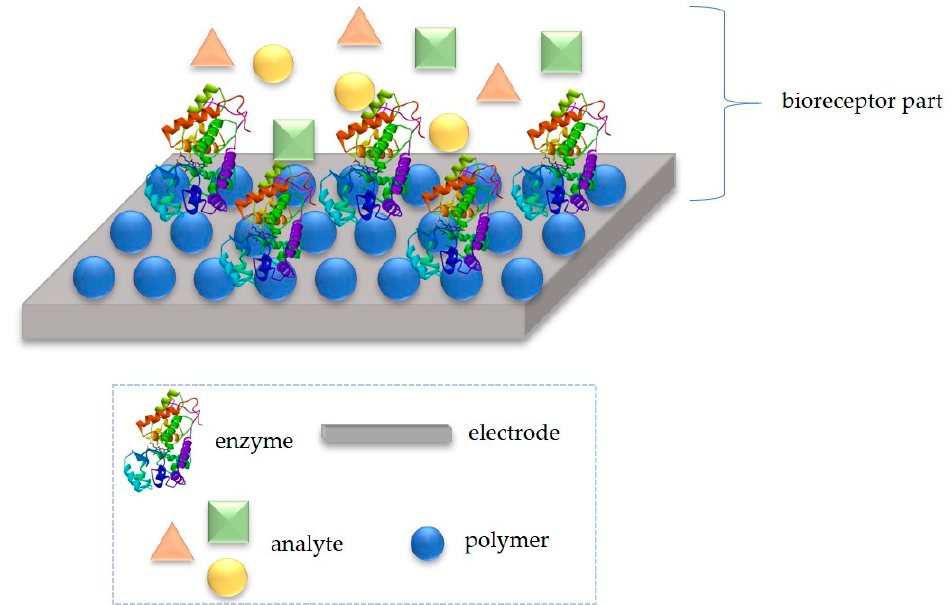
Figure 11. Example of bio-platform for a specific analyte recognition, which can be adopted in LOC device.